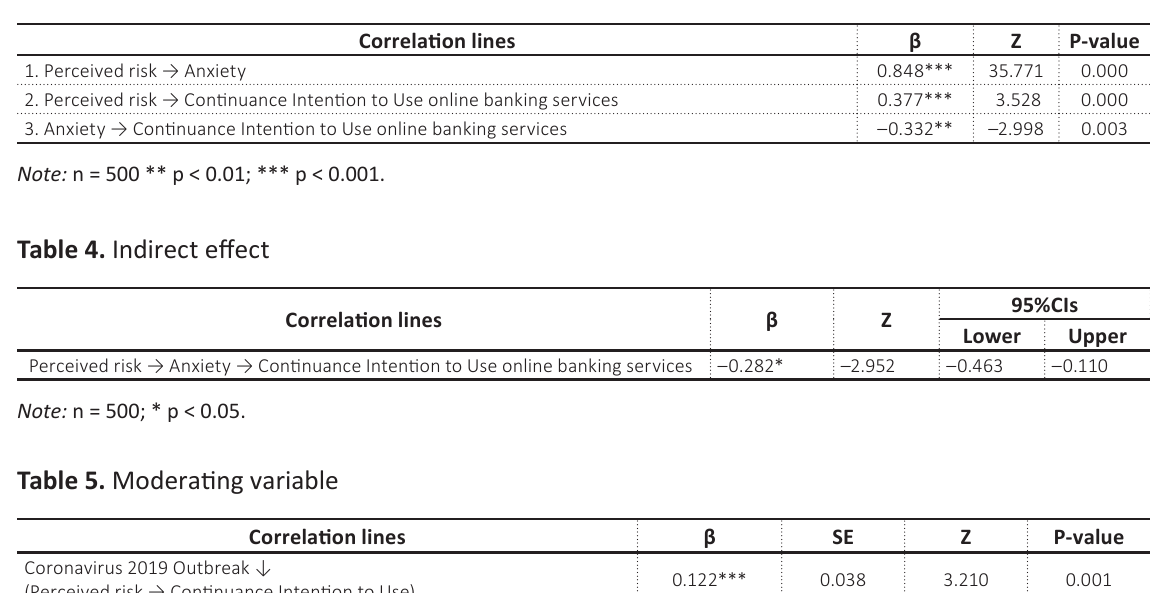
Table 3. Direct effect